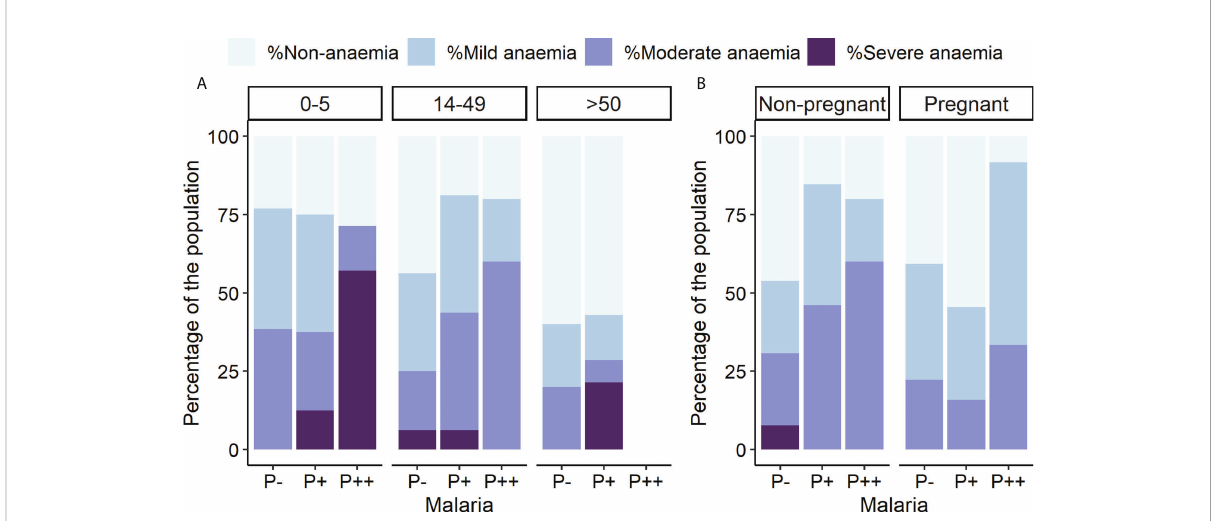
FIGURE 4 Anemia prevalence by parasitemia, age, and pregnancy groups. Rates of different anemia levels are indicated separately. P++, microscopic infections; P+, submicroscopic infections; P − , uninfected individuals. (A) Anemia levels by parasitemia and age groups. (B) Anemia levels by parasitemia and pregnancy groups.